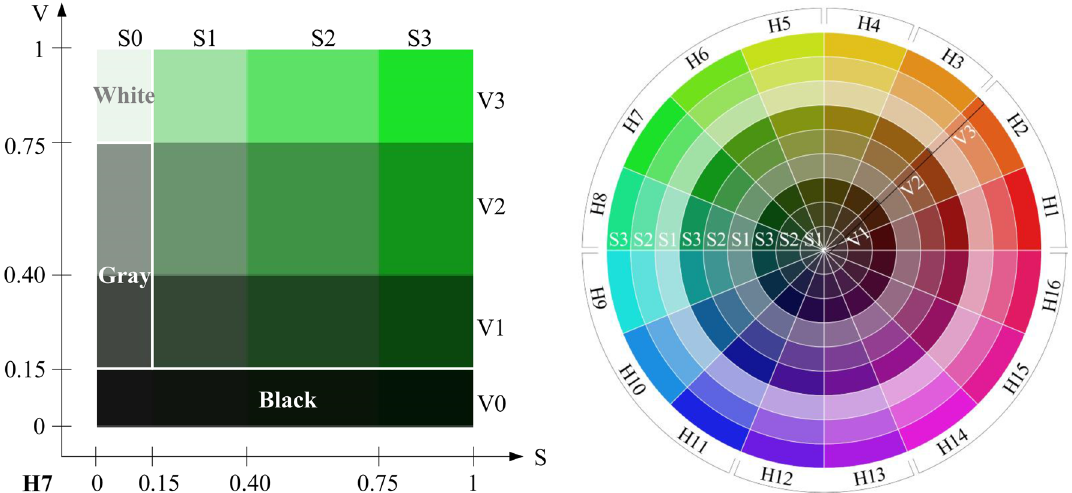
Figure 3. ( a ) Representative graph of 1 normalized (into black, white, and grays) color component index (H7) in the green hue category. S, saturation index; V, value index. ( b ) The 144 chromatic colors and the hue (H), saturation (S), and value (V) Indices used in our study. Adapted from Ref. 19 .